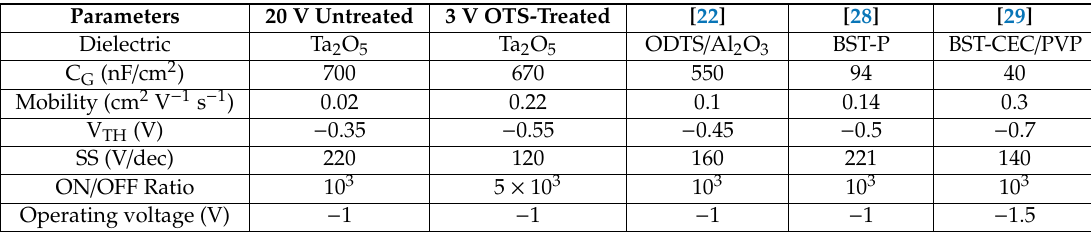
Table 1. Comparison of the DPPDTT-PMMA OTFTs’ performance with their counterparts in the literature.